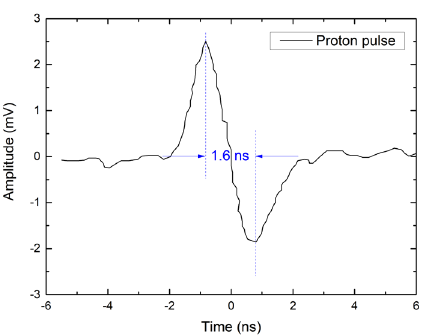
Figure 4. Signal induced into the Pick-Up by a proton pulse. It presents a peak-to-peak width of 1 . 6 ns.